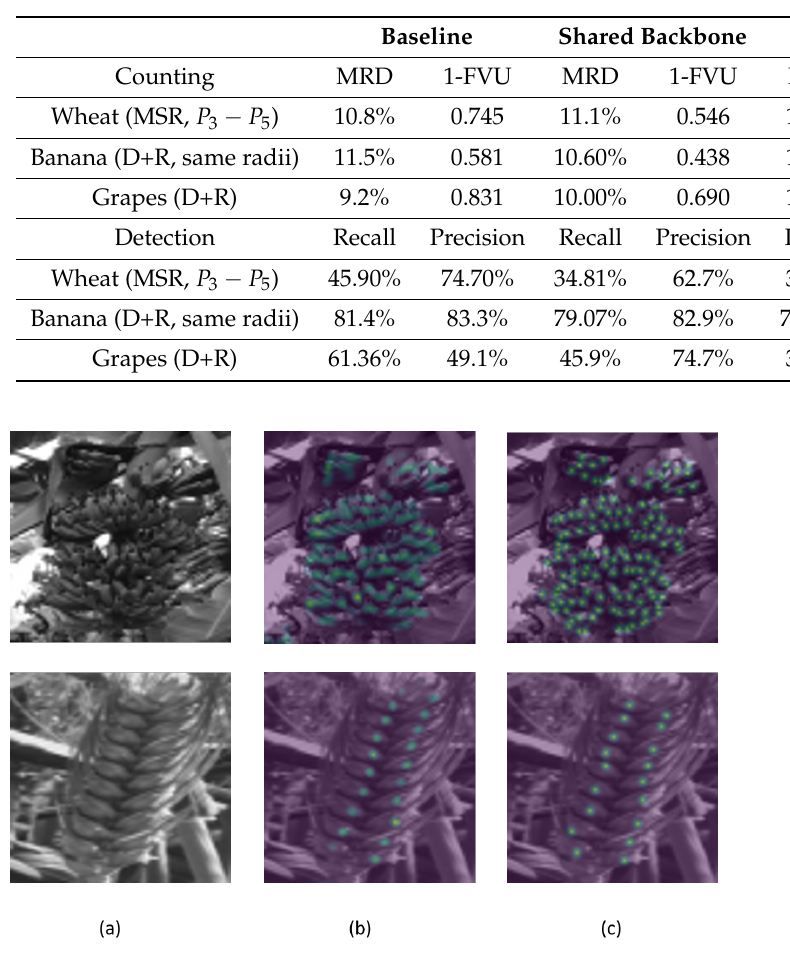
Table 7. Counting and detection results of network versions with shared components, compared to the baseline network. The upper half of the table compares counting accuracy. The lower half compares detection accuracy.